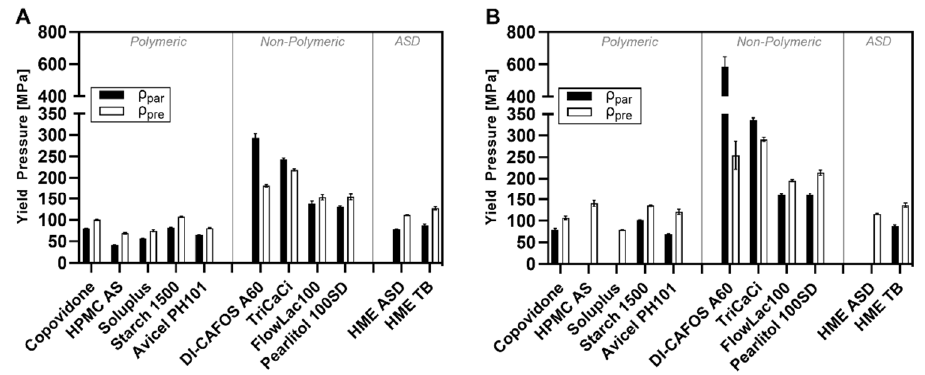
Figure 12. Yield pressure of excipients and HME ASD and HME TB at different compaction pressures ( A ) 100 MPa and ( B ) 300 MPa.